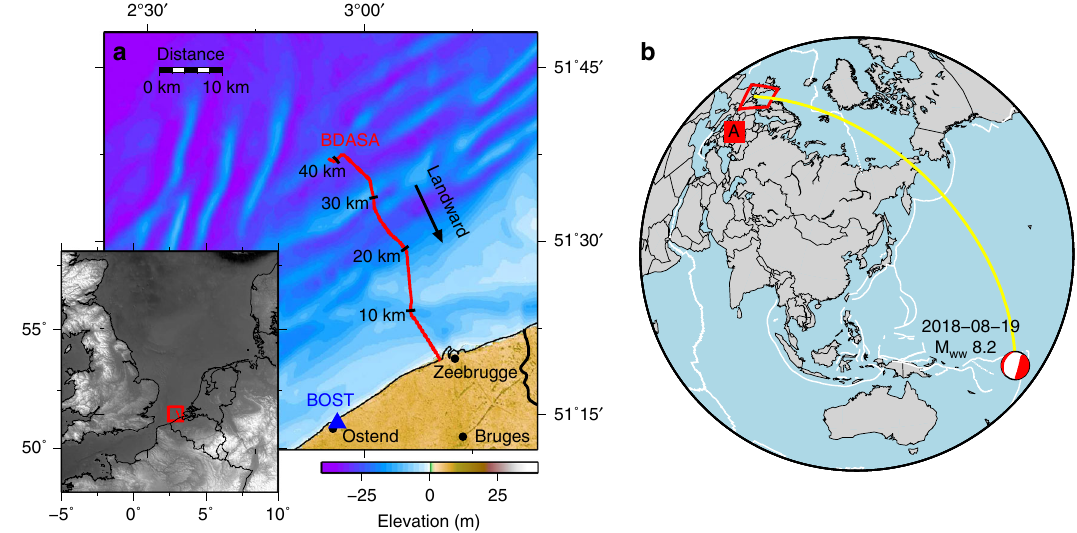
Fig. 1 Array location. a Local map showing the location Belgium Distributed Acoustic Sensing Array (BDASA, red line) and nearby broadband station BOST (blue triangle), with a regional map inset. b World map showing the location of the array (red box), the GCMT solution for the 2018-08-19 M w 8.2 Fiji deep earthquake, and great circle path between the earthquake epicenter and the array